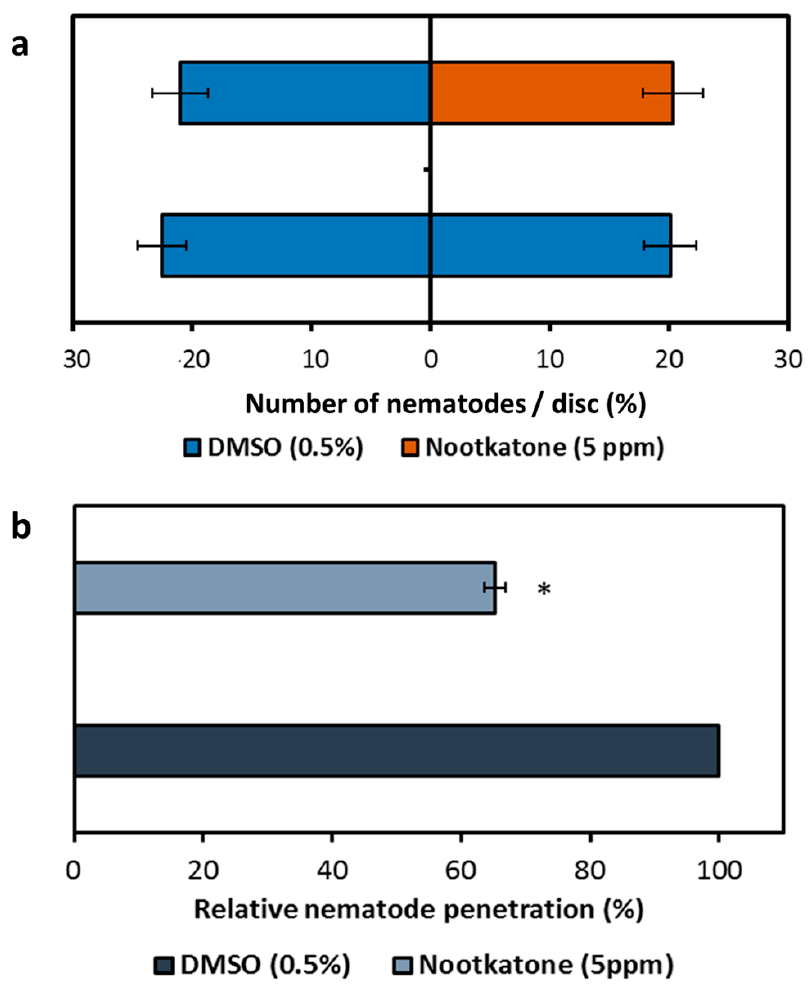
Figure 4. E ff ects of nootkatone presence in the growth medium on nematode behavior. ( a ) Chemotaxis analysis of Heterodera schachtii J2s towards Arabidopsis thaliana root-containing discs of Knop agar supplemented with nootkatone or DMSO. ( b ) Percentage of J2s’ penetrating roots of A. thaliana plants growing on Knop agar supplemented with nootkatone or DMSO. Values are means ± SE of 3 biological replicates, n = 27. The asterisk marks indicate significant di ff erences to the control based on a t -test ( p <